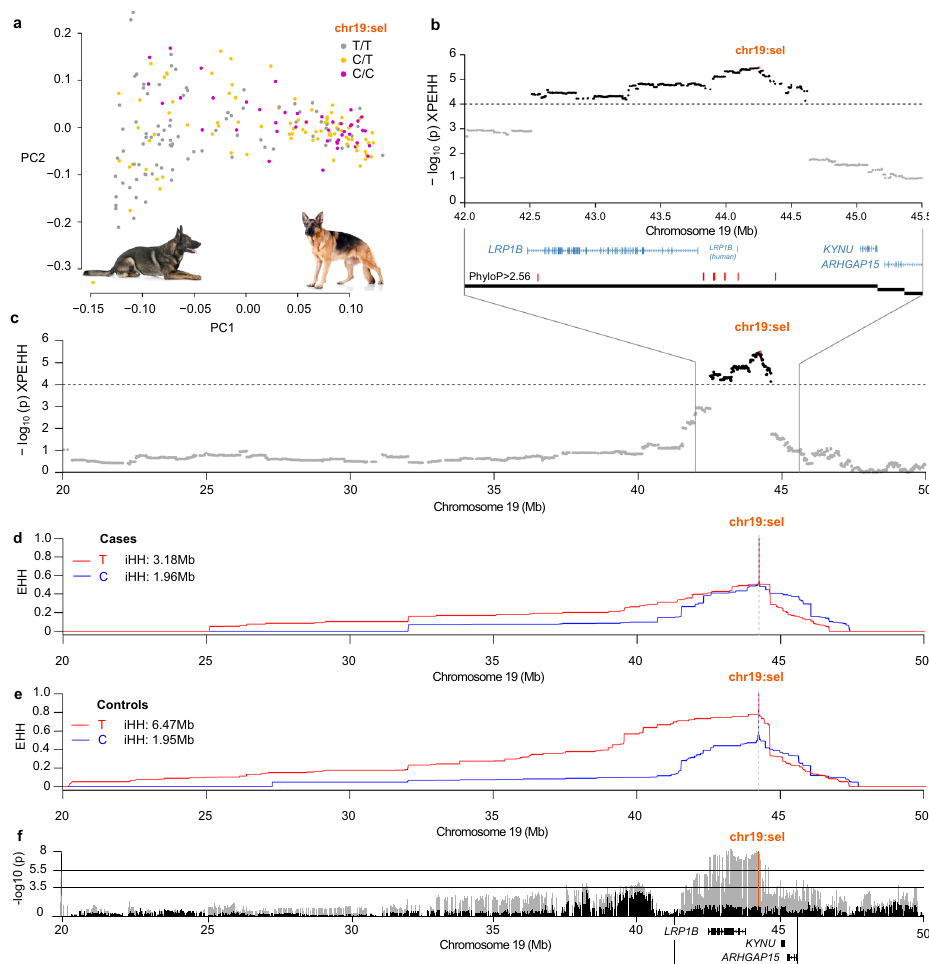
Fig. 5 A selection signal in German shepherd controls spans the LRP1B gene. Dogs from GSD kennels with a higher proportion of working compared to show merits and with gray or black coat color were more frequent in the low PC1 cluster whereas the opposite was seen for dogs in the high PC1 cluster (Supplementary Fig. 4). The subpopulations were subsequently referred to as the working (low PC1) and show (high PC1) type subpopulations. Dogs homozygous for the T allele were more frequent in the working type and the pictures illustrate the common gray color in a working type GSD and a show type with the typical GSD color pattern of brown with black saddle and a sloping cross ( a ). The selection signal on chr19 consisted of 1078 selection variants (-log 10 (p) XP-EHH ≥ 4) spanning the LRP1B gene and with the top selection variant located at chr19:44,248,511 (chr19:sel). The KYNU gene was positioned within the same canine liver TAD as LRP1B (black blocks). Red bars indicate selection variants with high phyloP scores (>2.56; b , c ). The iHH for chr19:sel for allele T in cases (3.18 Mb) was lower compared with controls (6.47 Mb) indicating selection in controls ( d , e ). The association with canine AD (plink --assoc model, gray bars) was high across LRP1B and overlapping with chr19:sel. The signal was lost in the logistic model (black bars) where PC1, PC2, -log 10 (IgA), and -log 10 (Age) were included as covariates. Protein coding genes are presented within the XP-EHH region (black box; f ; genes outside this region and three small transcripts without of fi cial gene symbols ( ENSCAFG00000024630, CFRNASEQ_PROT_00059550, and ENSCAFG00000030677 ) within the region were excluded from the